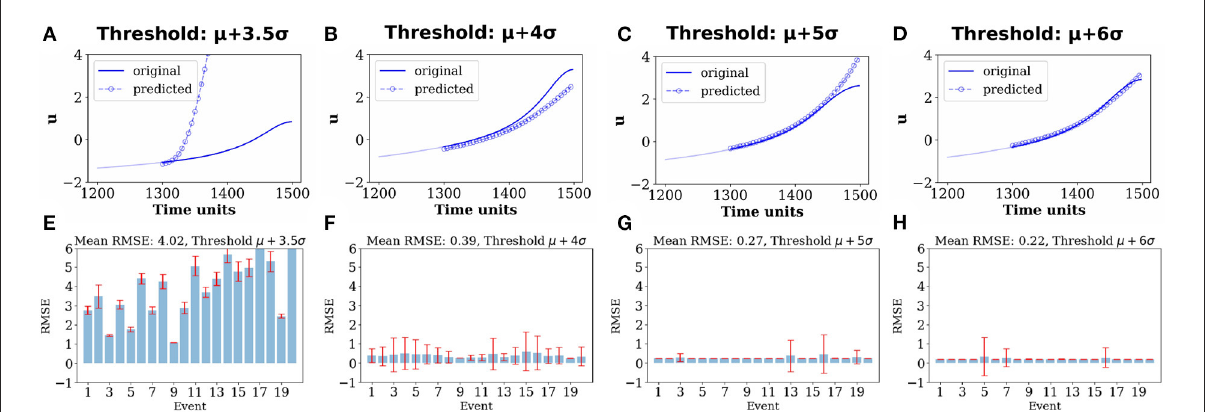
FIGURE3 Prediction of extreme events by the ESN. Upper panels in (A–D) show original active signal u for ( k − p ) = 200 data points (blue line) along with the predicted signal for ( k − p ) = 200 data points (blue circles) for comparison for EEs selected using four different threshold heights computed using: (A) d = 3.5, (B) d = 4, (C) d = 5, and (D) d = 6. It shows an increased resemblance between the predicted and original extreme peaks with increasing d . Lower panels in (E–H) show RMSE between the original signal u and their predicted signals for ( k − p ) = 200 data during testing,